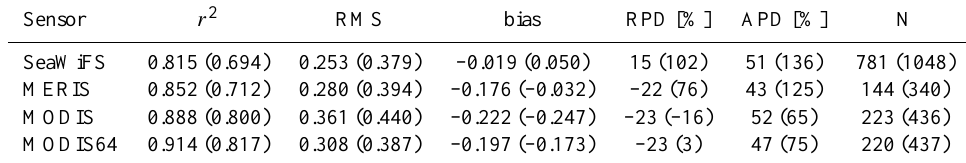
Table 4. Statistical results from the offline validation analysis. Numbers in and outside the brackets refer to the matchup statistics derived with NoFlags and standard approaches described in Sect. 3.1. Last row statistics refer to MODIS matchup file derived using SeaDAS version 6.4.